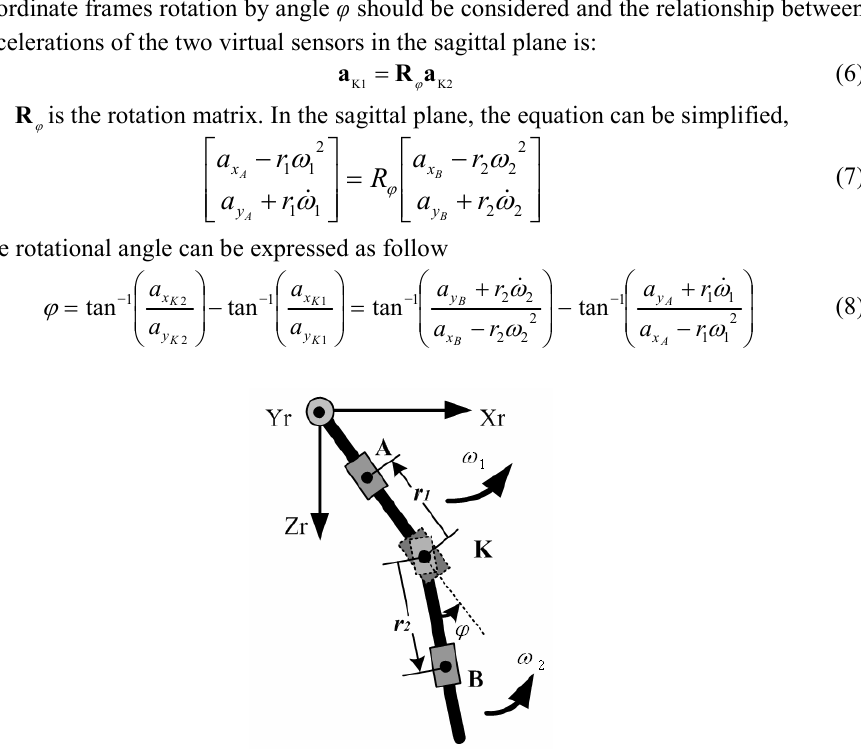
Fig.2 Virtual-sensor difference based method to calculate the knee joint angle in the sagittal plane. Two physical sensors were attached on the thigh and